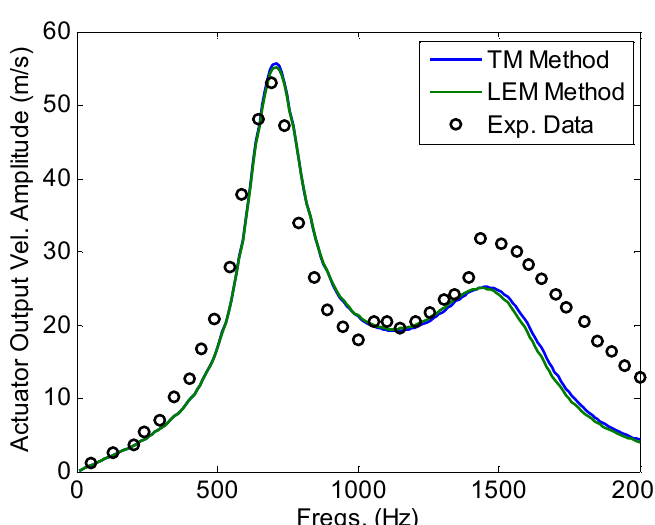
Fig.15 Comparison of TM, LEM and experimental data of jet velocity for a synthetic-jet actuator with side-mounted PZT disc (Case II).